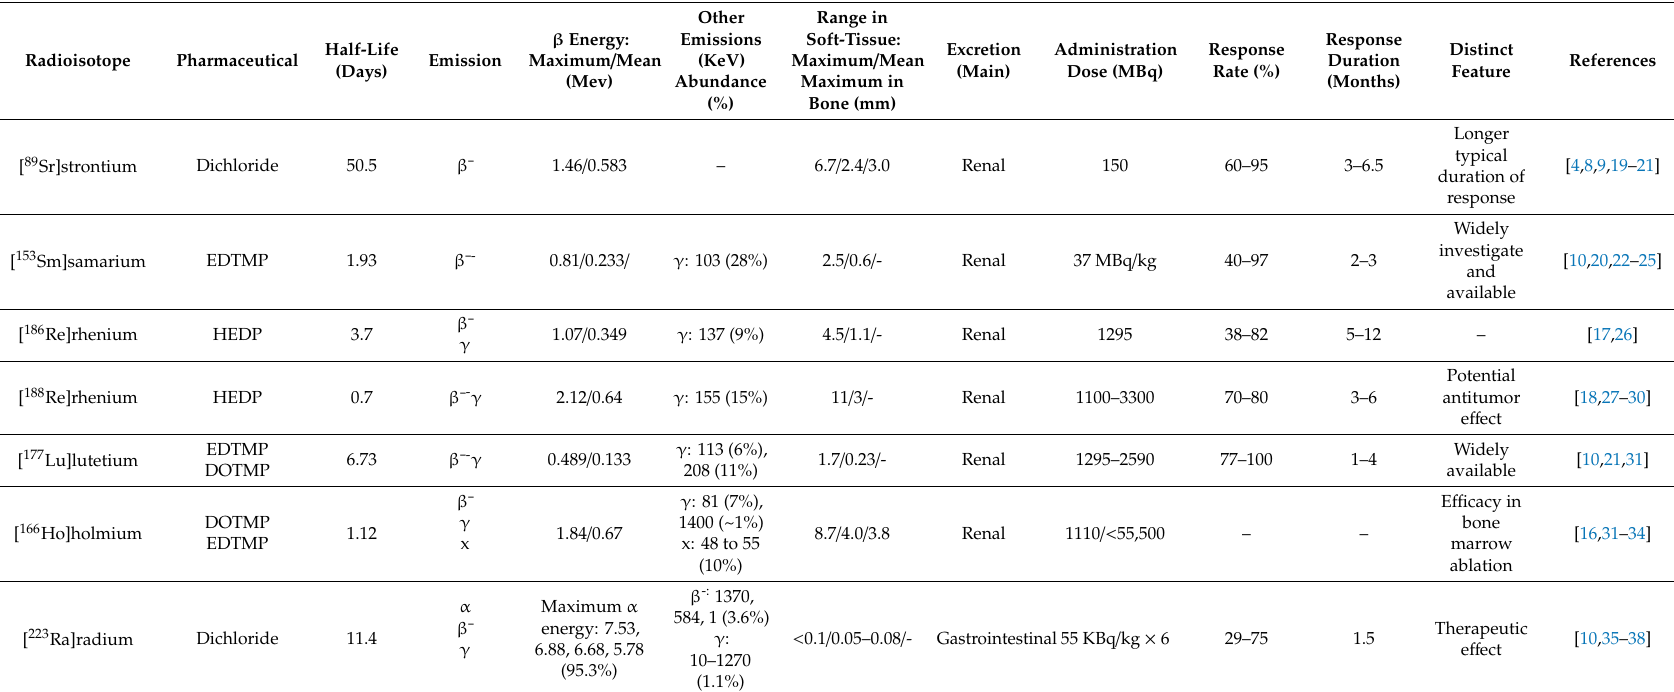
Table 1. Physical characteristics, e ffi cacy and toxicity of